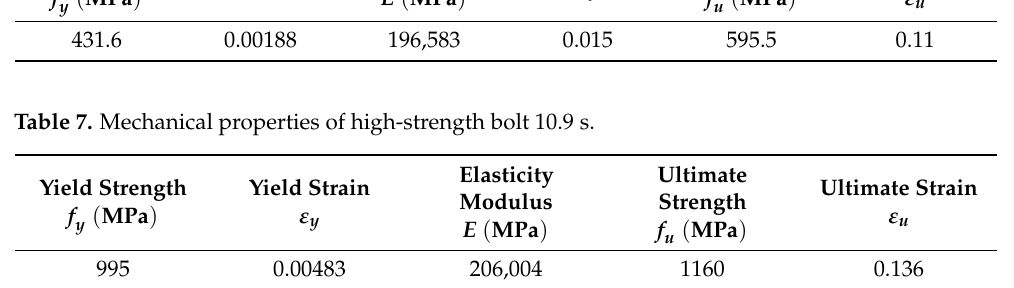
Figure 11. Material Model. ( a ) Material model of Q355 steel, ( b ) Material model of high-strength bolt. Table 6. Mechanical property parameters of steel material Q355.